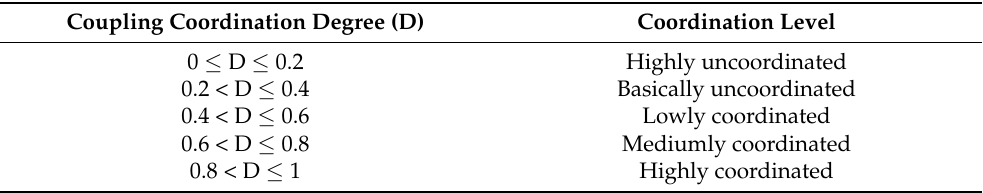
Table 4. Types and levels of development of coupling and coordination between ESV and socioeco- nomic